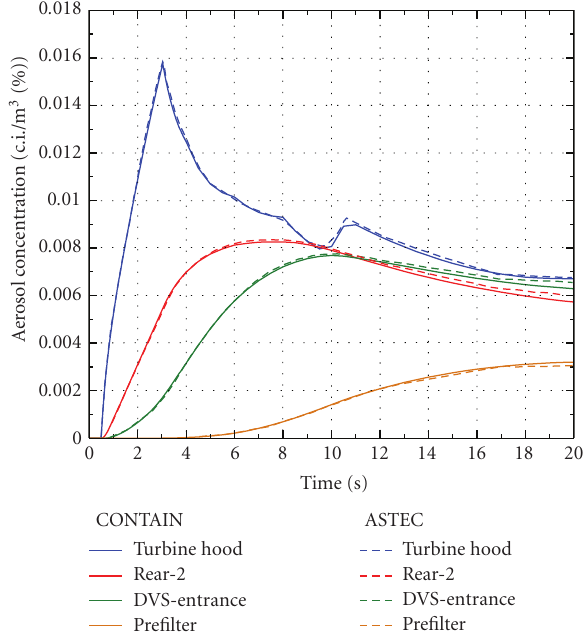
Figure 6: Airborne aerosol concentration evolution in the main confinement compartments for the LB